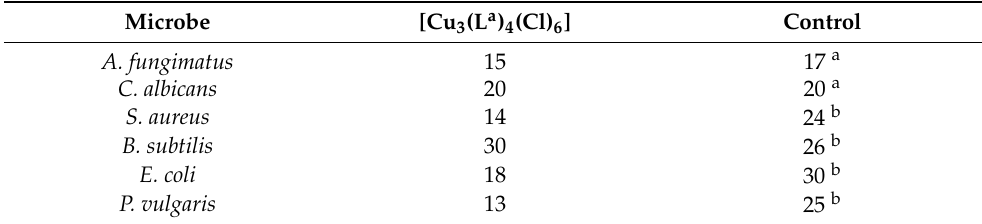
Table 4. Zone of inhibition (in mm) for the [Cu 3 (L a ) 4 (Cl) 6 ] complex.